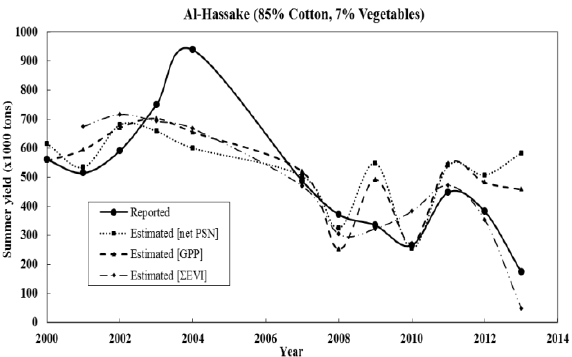
Figure 1- Time series of reported and simulated summer crop yields for Hama governorate (2000-2013).